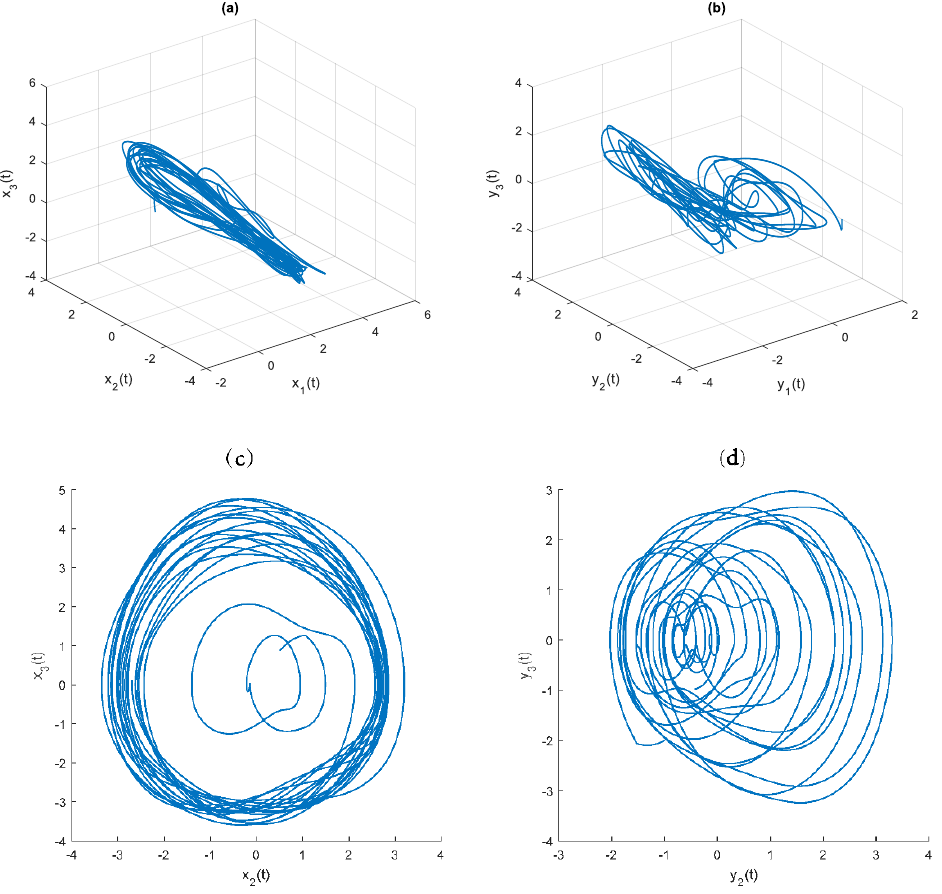
Figure 1. Exhibits chaotic behaviors of the fractional-order modified Jerk system without the controller. ( a ) The phase portrait of the master system (25), ( b ) the phase portrait of the slave system (26), ( c ) the plan 𝑥 2 − 𝑥 3 of master system, and ( d ) the plan 𝑦 2 − 𝑦 3 of the slave system.